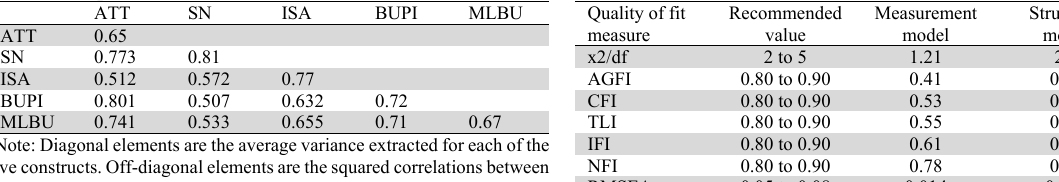
AVE and square of correlations between constructs. Fit indices for measurement and structural